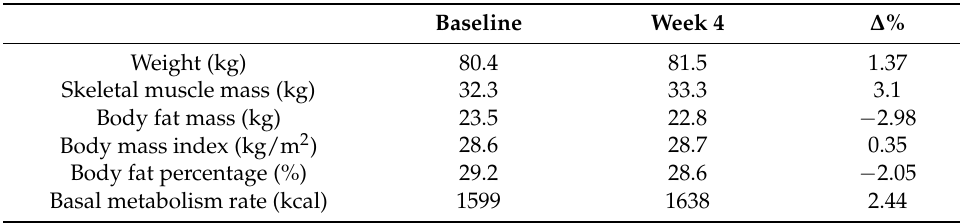
Table 4. Changes in body composition.